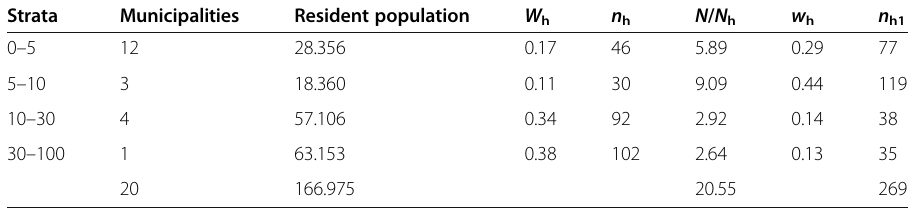
Table 3 Allocation of the sample units in the layers. Inverse-proportional stratified sampling